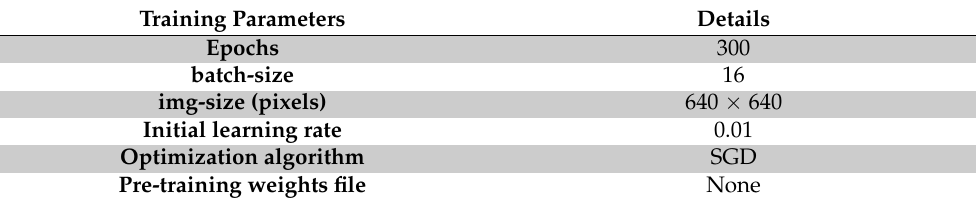
Table 2. Training parameters of the forest fire detection model.